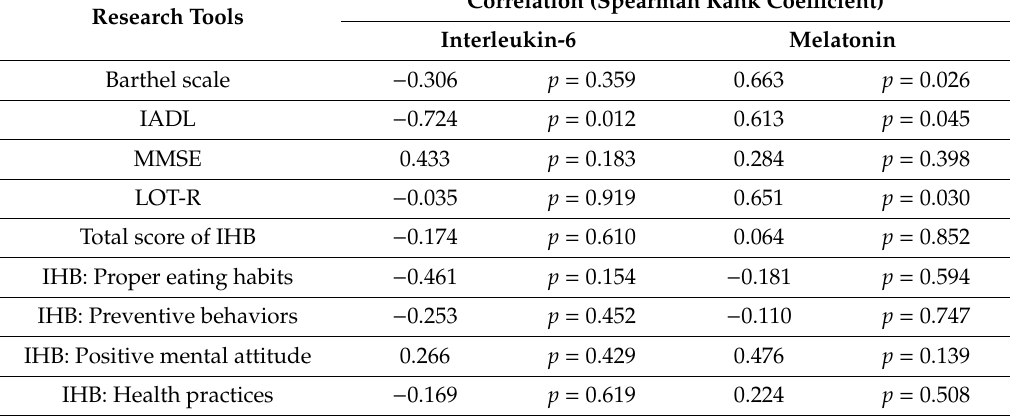
Table 8. The relationship between the level of interleukin-6 and melatonin and the results obtained from standardized research tools among respondents over 75 years old belonging to the comparative group (n =